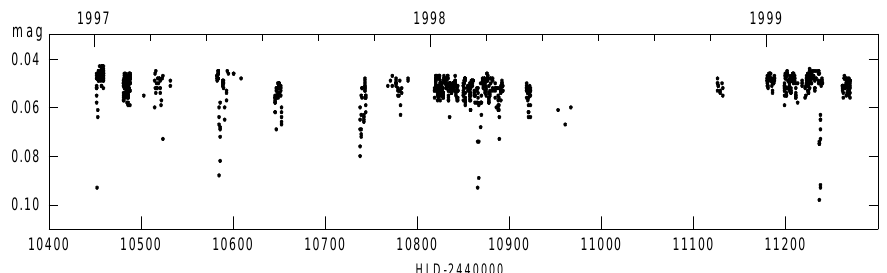
Fig. 6. y magnitude differences between 13 . (cid:2)(cid:2) 3 and the 23 . (cid:2)(cid:2) 0 apertures (Sterken et al.